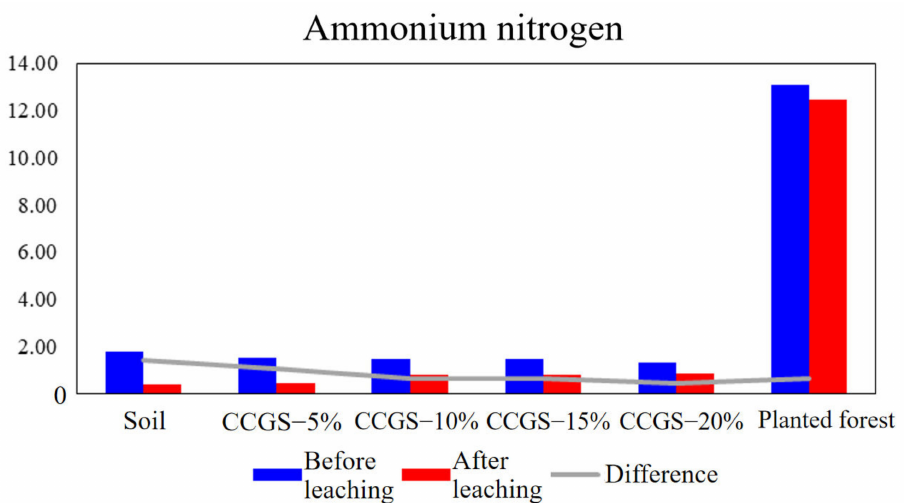
Figure 16. Effect of CCGS on ammonium nitrogen.